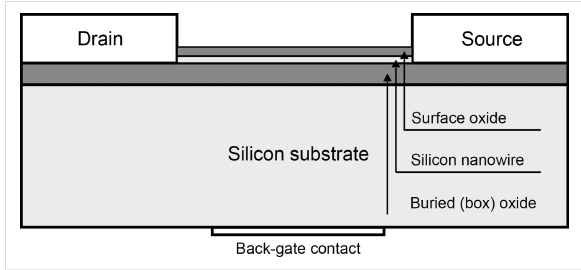
Figure 1: Conceptual diagram of a SiNW